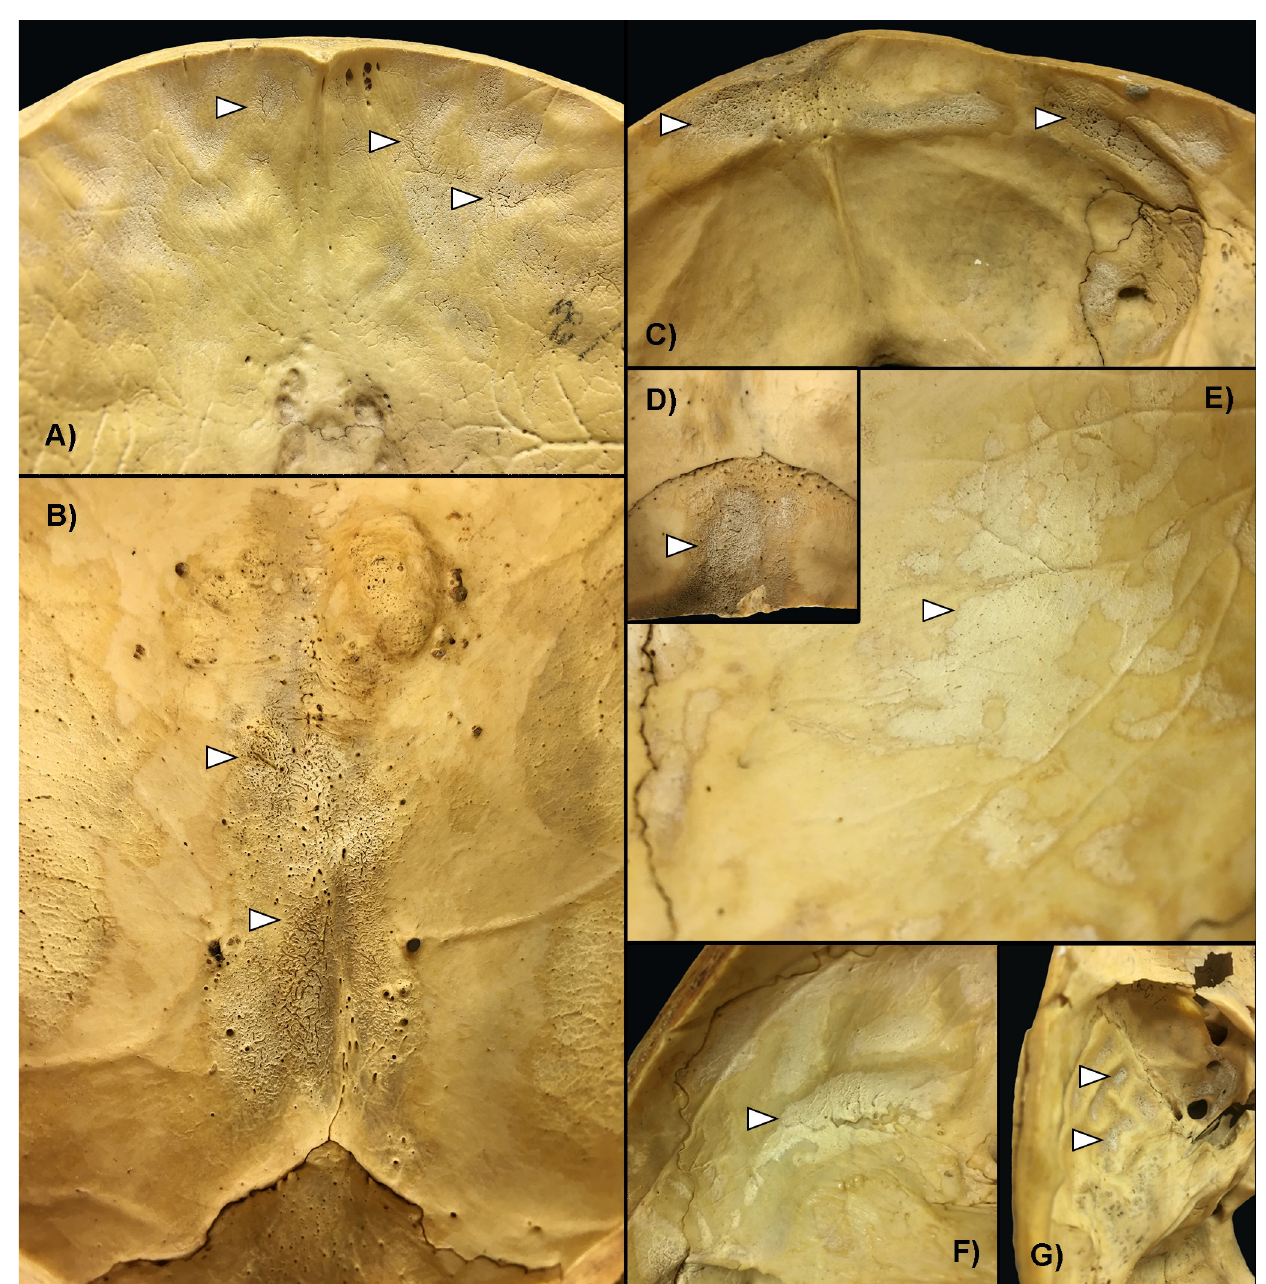
Fig 3. Typical localizations of ABVIs and PAs (white arrows) on the inner surface of the skull. A) The squamous part of the frontal bone (Terry No. 304, 20-year-old, female, died of pulmonary TB); B) The area along the superior sagittal sinus on the parietal bones (Terry No. 1222, 28-year-old, female, died of pulmonary TB); C) The squamous part of the occipital bone (lower part) (Terry No. 1322, 34-year-old, male, died of pulmonary TB); D) The squamous part of the occipital bone (upper part) (Terry No. 1322, 34-year-old, male, died of pulmonary TB); E) The most protruding portion of the parietal bone (Terry No. 987, 23-year-old, male, died of pulmonary TB); F) The squamous part of the temporal bone (Terry No. 987, 23-year-old, male, died of pulmonary TB); and G) The squamous part of the temporal bone and the greater wing of the sphenoid bone (Terry No. 1322, 34-year-old, male, died of pulmonary